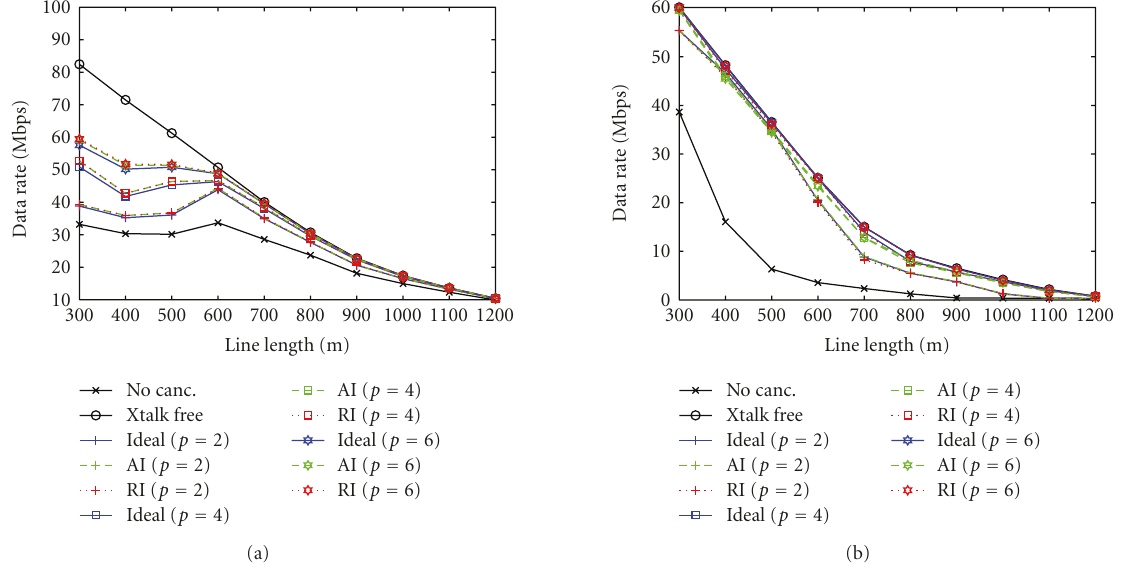
Figure 4: Data rates for LS scheme using the proposed AI and RI CMI methods compared to the ideal solution for distributed Scenario 1: (a) downstream and (b) upstream.